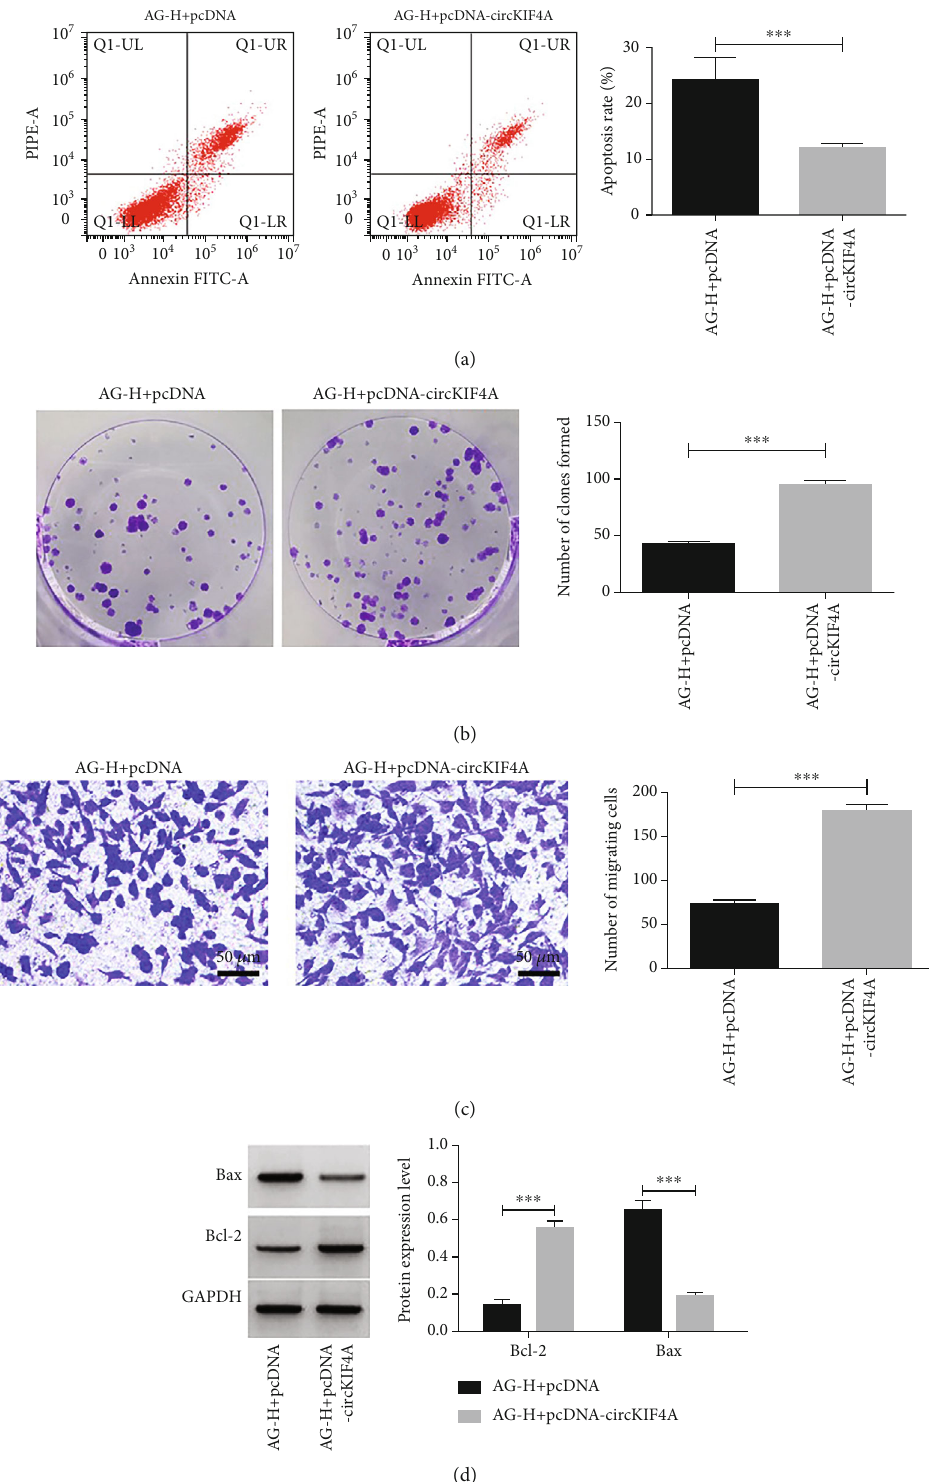
Figure 6: Impact of circKIF4A on Amarogentin (AG)-intervened HGC-27 cell apoptosis, clone formation and migration. a: Impact of circKIF4A on AG-intervened HGC-27 apoptosis. b: Impact of circKIF4A on AG-intervened HGC-27 clone formation number. c: Impact of circKIF4A on AG-intervened HGC-27 migration number. d: Impact of circKIF4A on Bax andBcl-2 protein in AG-intervened HGC- 27. ∗∗∗ P <